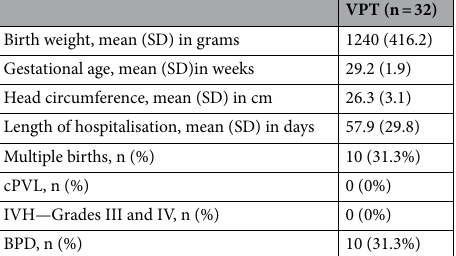
Table 2. Detailed neonatal characteristics of the VPT group. cPVL Cystic periventricular leukomalacia, IVH intraventricular haemorrhage, BPD bronchopulmonary dysplasia.